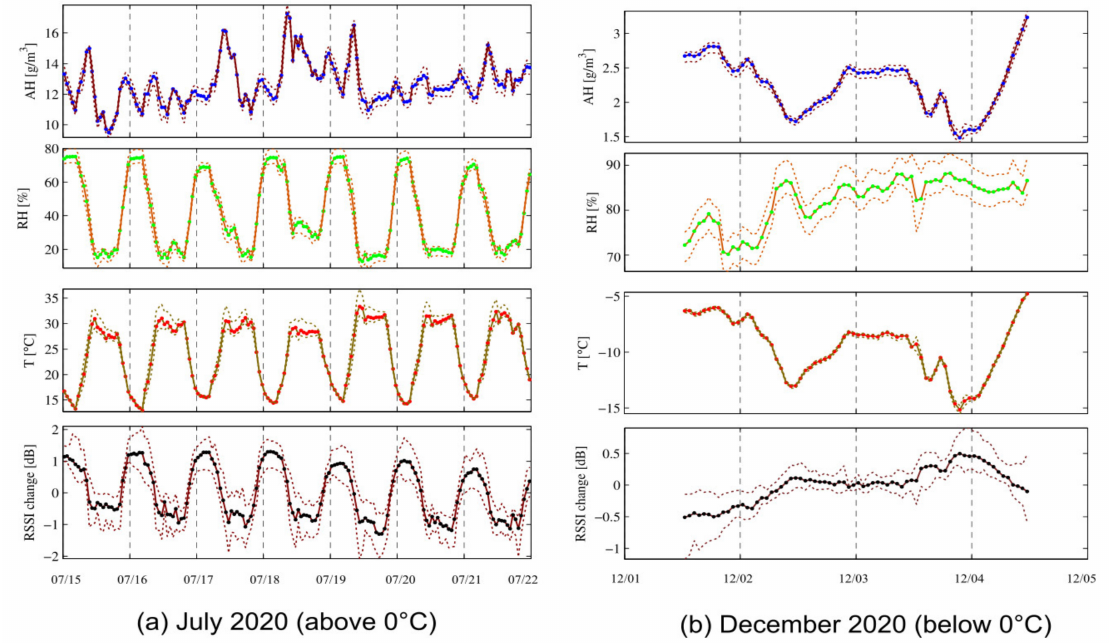
Figure 17. Representation of RSSI change, temperature, RH and AH in two representative months, July and December,